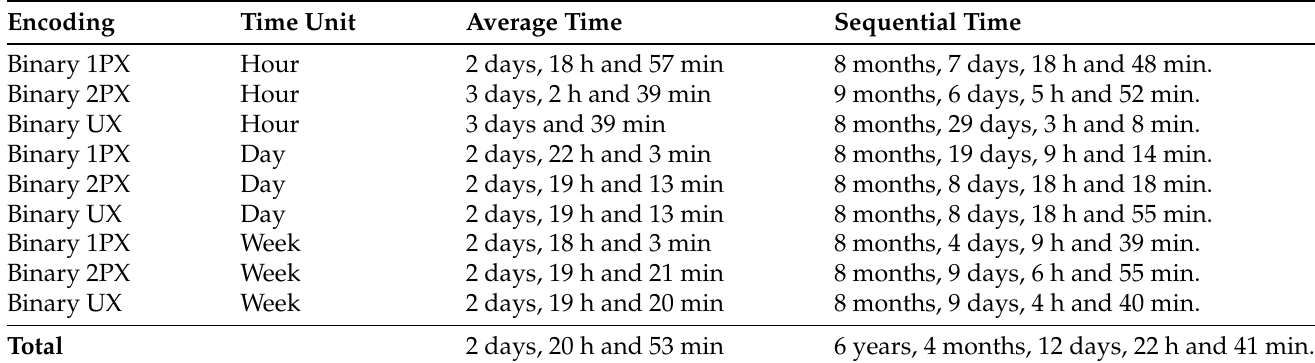
Table 9. Computational time